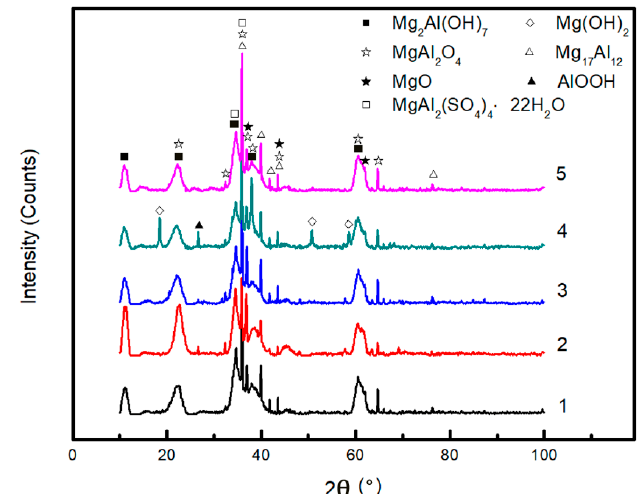
Figure 15. XRD patterns for the product of AZ91D after immersed in simulated HA solution ( 1 ), and at the shortage of SO 2-